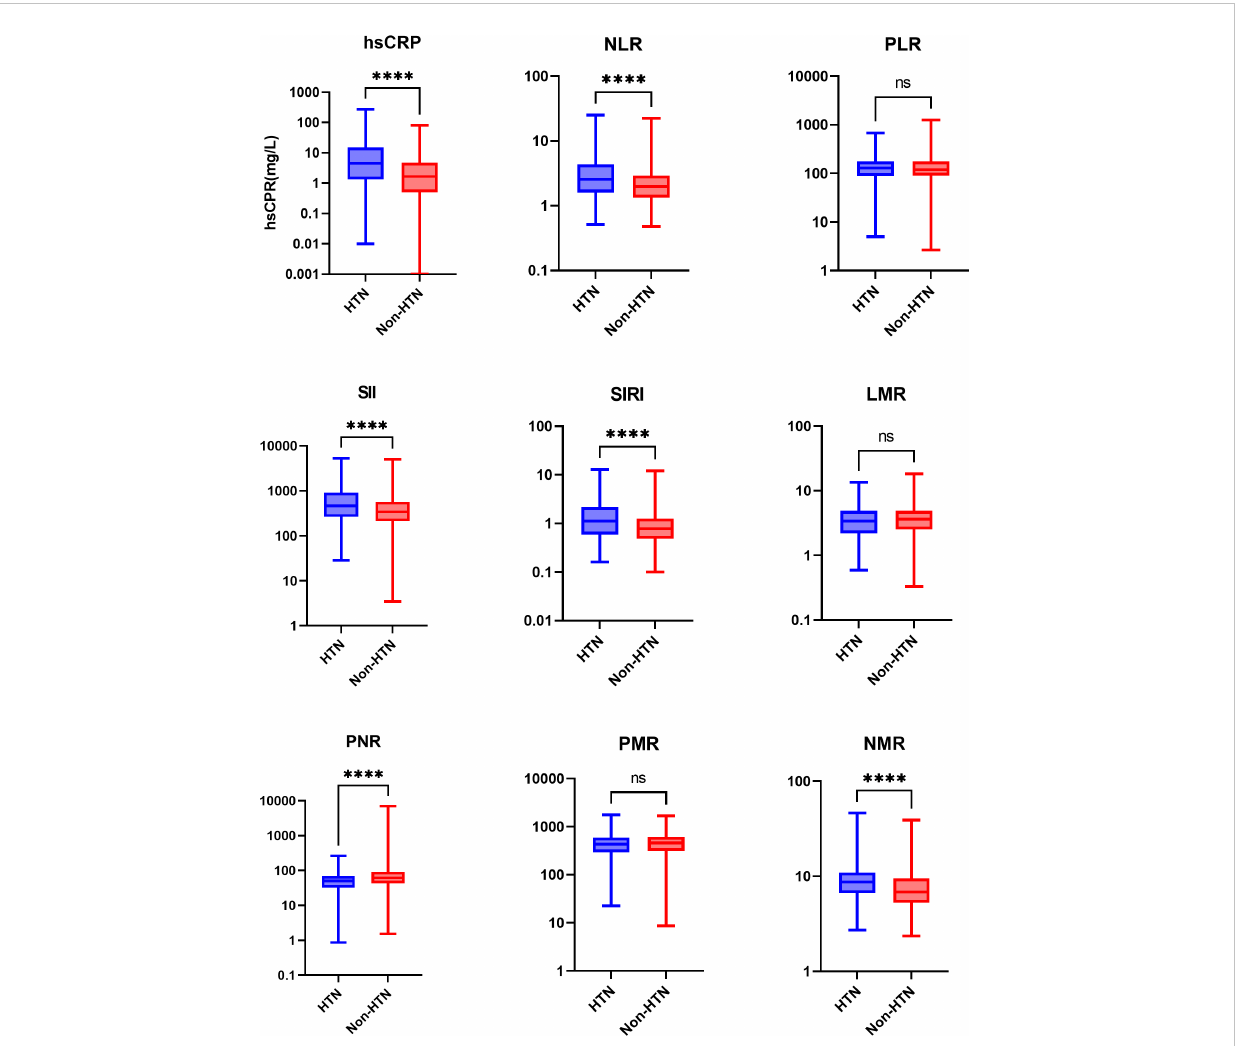
FIGURE 2 Boxplots comparing the in fl ammation marker levels of the two groups. Values are presented as median (IQR). log-transformed, **** P <0.0001, and ns, not signi fi cant. HTN, the hypertension group; Non-HTN, the non-hypertension group; hsCRP, high-sensitivity C-reactive protein; NLR, neutrophil-to- lymphocyte ratio; PLR, platelet-to-lymphocyte ratio; SII, systemic immune-in fl ammation index; SIRI, systemic in fl ammation response index; LMR, lymphocyte-to-monocyte ratio; PNR, platelet-to-neutrophil ratio; PMR, platelet-to-monocyte ratio; NMR, neutrophil-to-monocyte